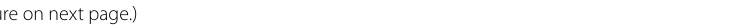
figure on next Fig. 3 Result for case 1 ( A tr 100 Ma, σ yield 200 MPa and φ AL 0.1). a – g Time evolution of slab geometry. Insets show enlargements of the arc = = = area (shown by a square). The distribution of effective viscosity is indicated by different colors and arrows indicate the velocity field. HB buckled slab, BF buckled falling slab. h Upper panel shows change in velocities of the subducting plate ( V sp ), the overriding plate ( V op ) and the = trench ( V tr ), in addition to the average dip angle of the slab surface (Dip) measured in the depth range 200–300 km. Arrows a-g correspond to the time for Fig. 3a–g. Lower panel shows the change in the maximum (Max), minimum (Min) and average (Ave) values of horizontal stress in the arc area (50 km width and 30 km depth). A positive value indicates tensional stress. Arrows correspond to the time shown in Fig. 3i. i Distribution of horizontal stress ( σ xx ) in the